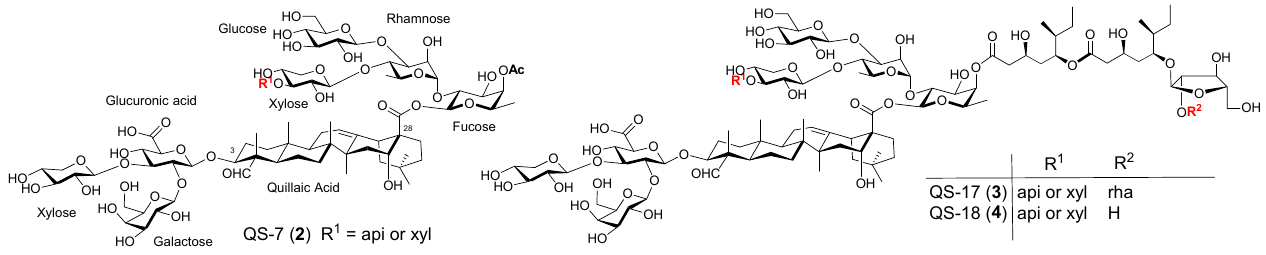
Figure 2. Natural QS saponins QS-7, QS-17, and QS-18.